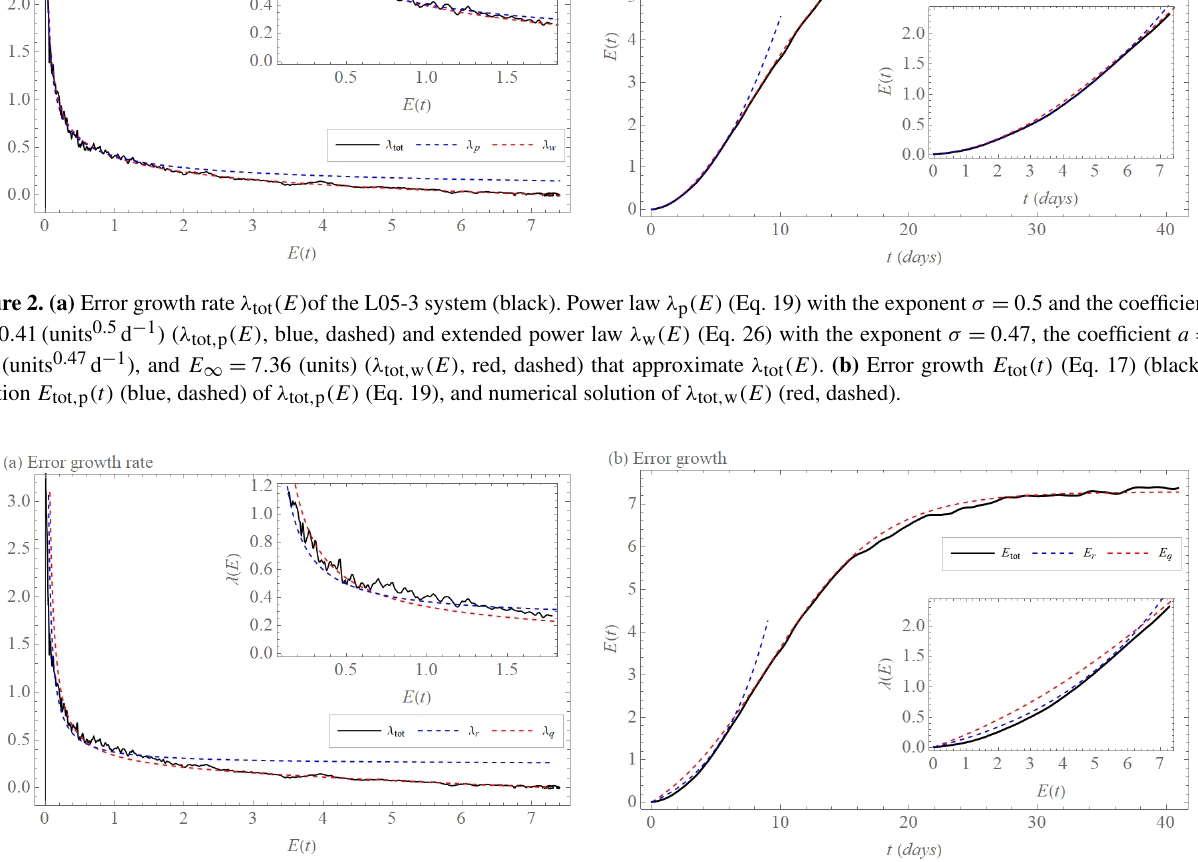
Figure 3. (a) Error growth rate λ tot (E) of the L05-3 system (black). Quadratic model λ r (E) (Eq. 22) with α = 0 . 25(d − 1 ) and β = 0 . 13(units per day) ( λ tot , p (E) , blue, dashed) and extended quadratic model λ q (E) (Eq. 20) with α = 0 . 2(d − 1 ), the coefficient β = 0 . 19(units per day), and E ∞ = 7 . 3(units) ( λ q, w (E) , red, dashed) that approximate λ tot (E) . (b) Error growth E tot (t) (Eq. 17) (black), solution E tot , r (t) (blue, dashed) of λ tot , r (E) (Eq. 22), and solution E tot , q (t) (blue, dashed) of λ tot , q (E) (Eq. 21) (red,